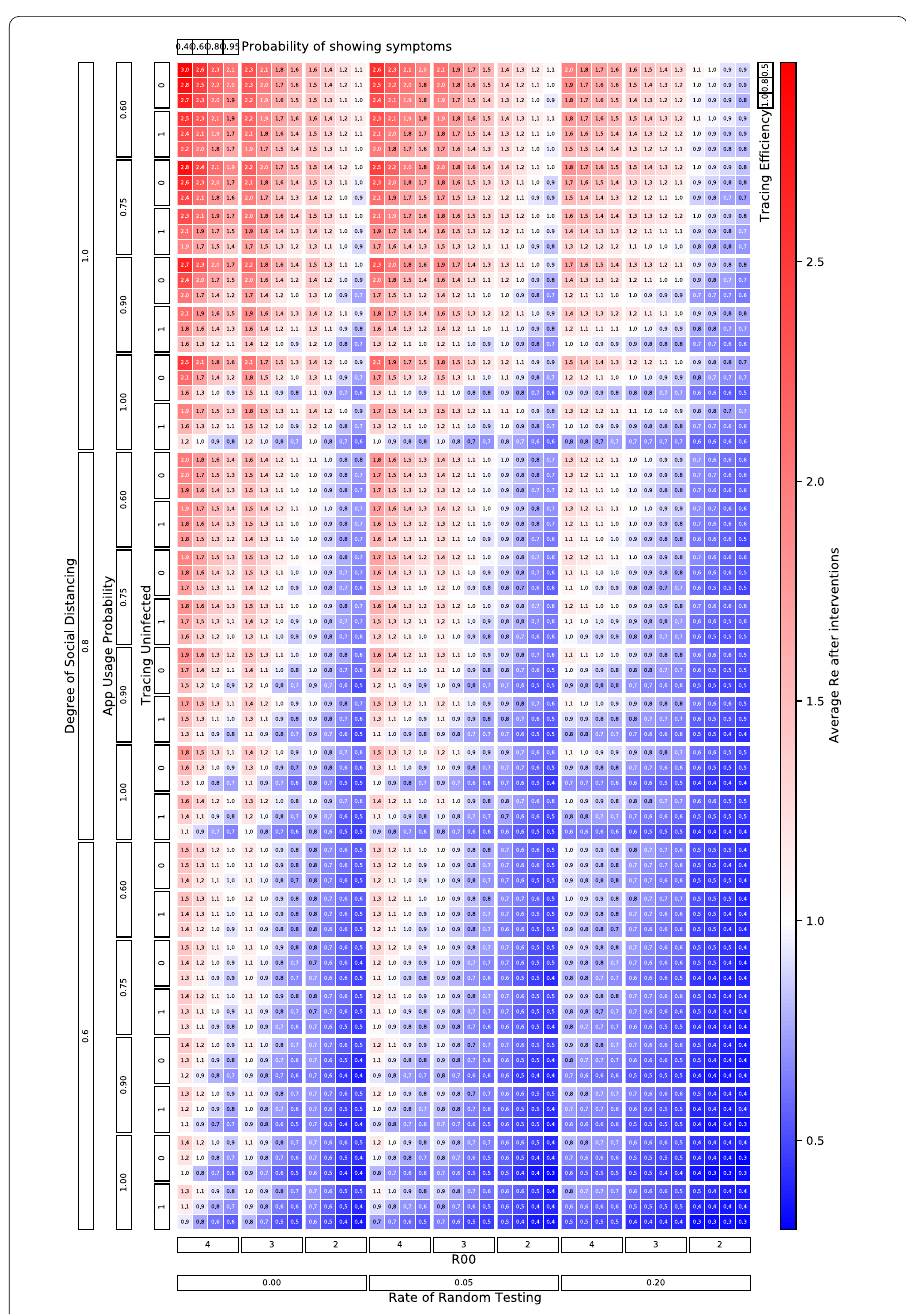
Figure 23 The effective reproductive number reached once interventions are turned on is shown for all combinations of parameters in the default parameter scan (black font color in Tab. 1)